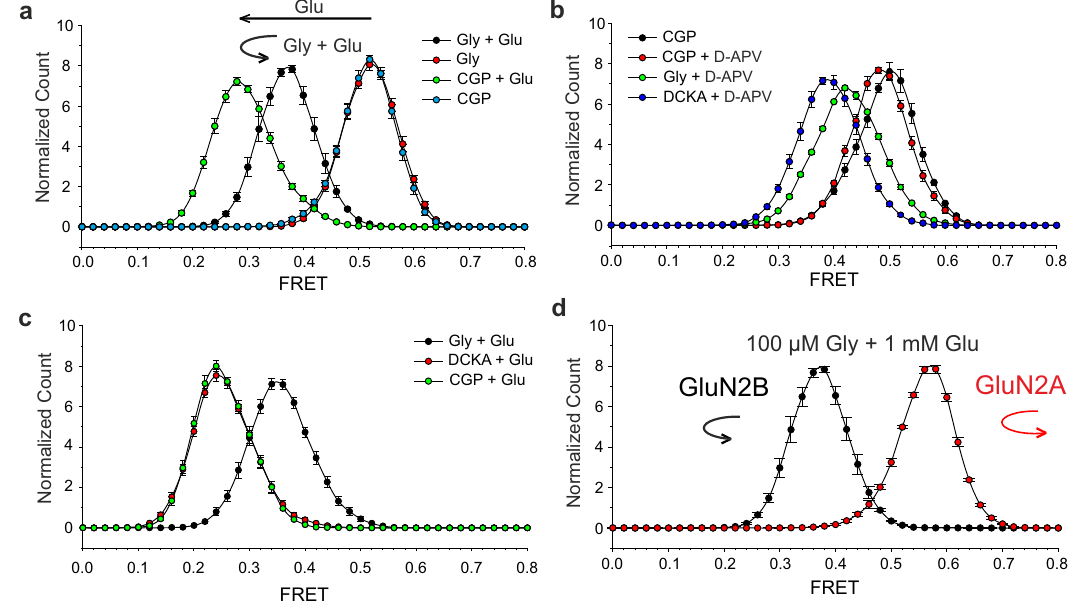
Fig. 4 ATD dimer motion across activation states. a Glycine permits a different glutamate conformational pathway of activation. In all, 100 µ M glycine alone (GluN1-closed gly /GluN2B-open empty , red) evokes no detectable FRET change (same as GluN1-open CGP /GluN2B-open empty , blue). In all, 100 µ M glycine + 1 mM glutamate (GluN1-closed gly /GluN2B-closed glu , black) increases FRET compared to 1 mM glutamate alone (GluN1-open CGP /GluN2B- closed glu , green). Each histogram n = 5 movies, SEM error bars. b GluN2-competitive antagonist D-APV mimics an early stage of activation. GluN1- competitive antagonist DCKA increases ATD separation induced by D-APV indicating positive cooperativity between the GluN1 and GluN2B subunits. D- APV allows glycine to induce partial rotation (pH 8.5). Each histogram n = 5 movies, SEM error bars. c Neither CGP nor DCKA is capable of unlocking GluN1 to allow rotation (pH 8.5). Each histogram n = 5 movies, SEM error bars. d FRET histograms of SNAP_GluN1-1a/GluN2B ( n = 5 movies, SEM error bars) versus SNAP_GluN1-1a/GluN2A ( n = 5 movies, SEM error bars) receptors, in the presence of 100 µ M glycine and 1 mM glutamate. GluN2A containing receptors exceeds the degree of rotation of the GluN2B in the presence of 100 µ M glycine and 1 mM glutamate. Ligands were used at the following concentrations: 100 µ M Gly, 1 mM Glu, 3 µ M CGP, 100 µ M DCKA, and 500 µ M